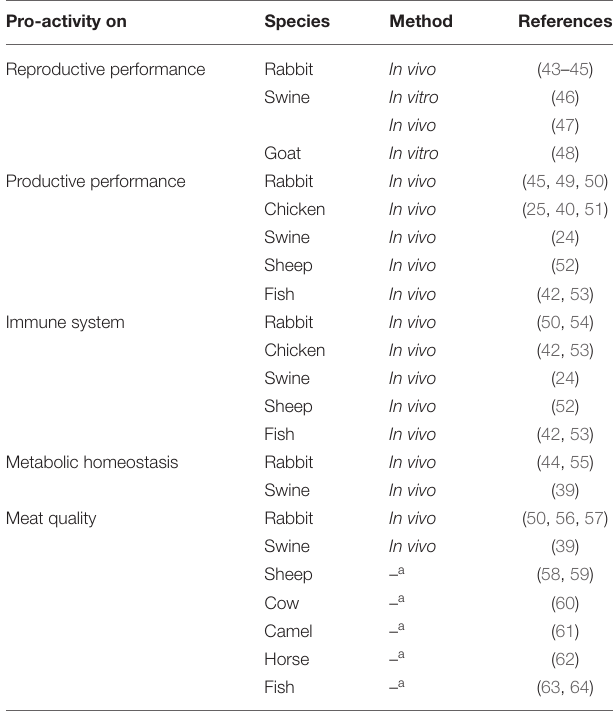
TABLE 1 | Summary of the main experimental studies investigating Lycium plant pro-activities on livestock animals. Pro-activity